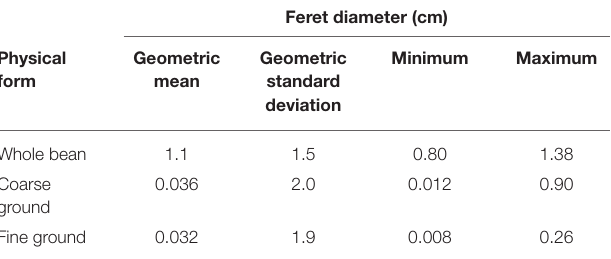
TABLE 3 | Particle size measured as Feret diameter (cm) for whole bean, coarse ground, and fine ground forms of roasted